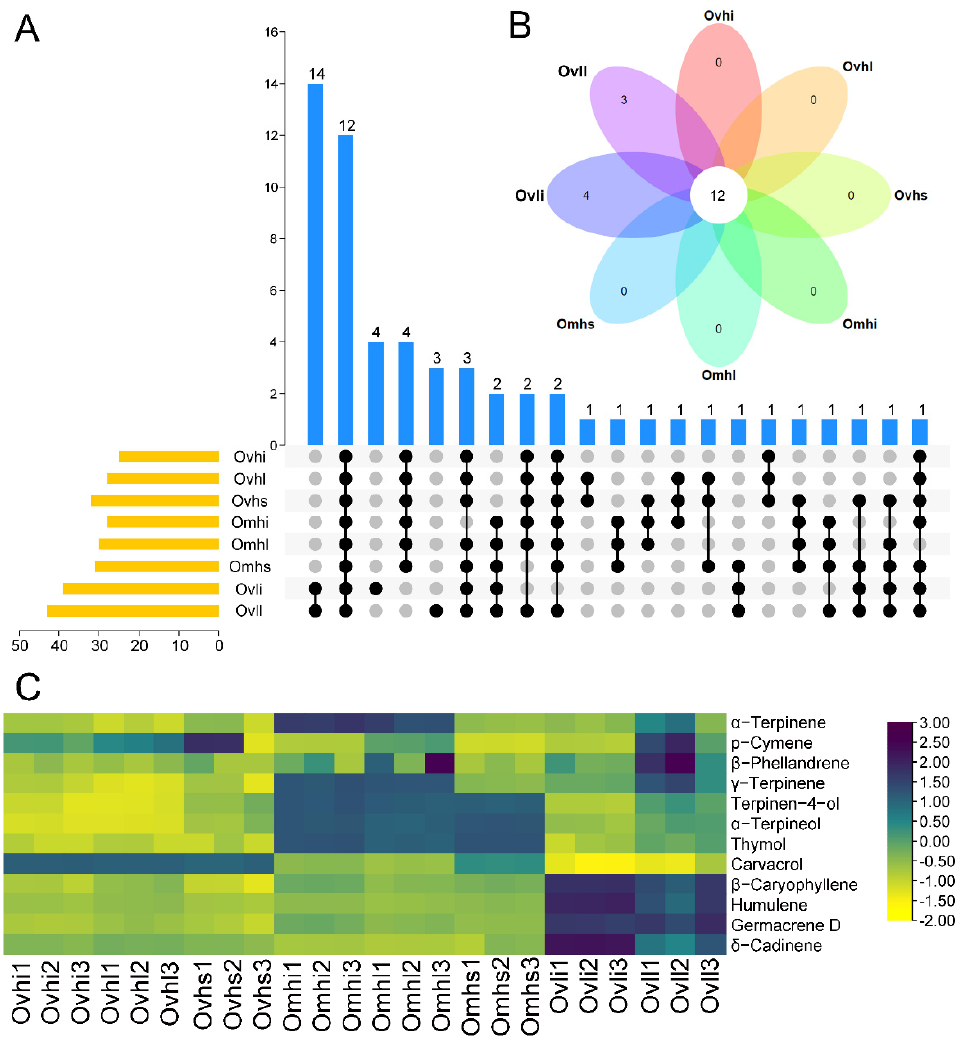
Figure 3. UpSet plot ( A ) and flower plot ( B ) based on amounts of chemical components in OEOs. Heatmap ( C ) of shared component contents in all samples.